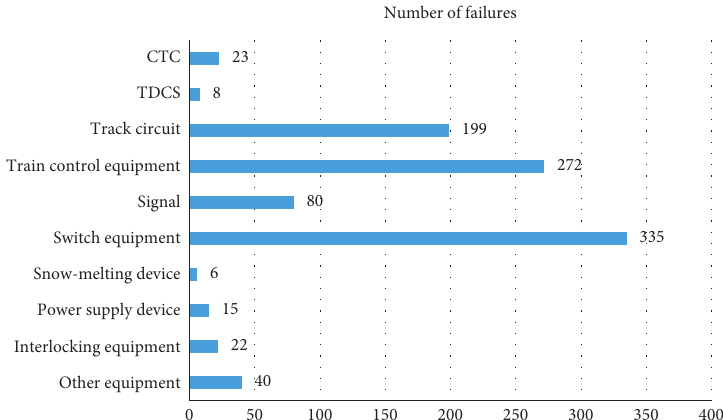
Figure 1: The distribution of signal equipment failures recorded by the Lan-Xin High-speed Railway Signaling and Communications Department from 2017 to